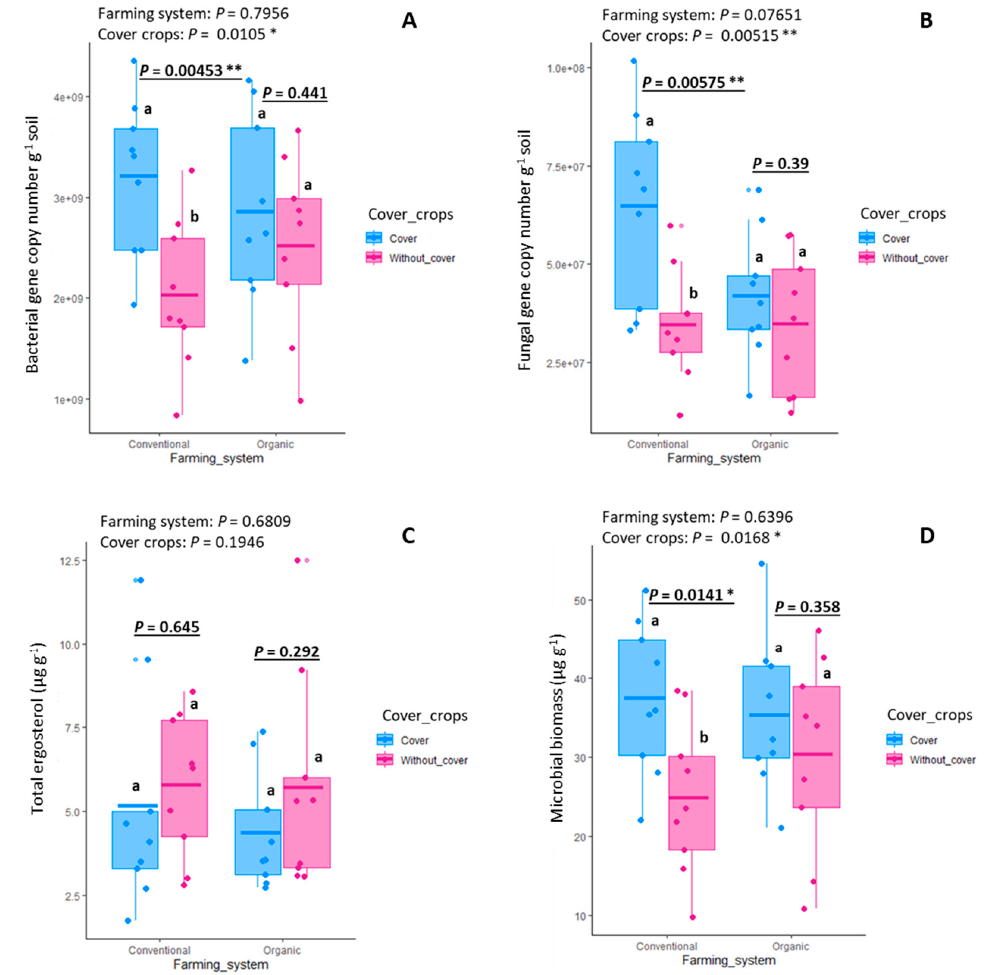
Figure 1. Effect of cover crops on bacterial abundance (16S rRNA) ( A ), fungal abundance (18S rRNA) ( B ), ergosterol content ( C ) and microbial biomass ( D ) in soil from the two farming systems (conventional and organic). The boxplot with p-values represents means of each modality using ANOVA ( n = 36). Means followed by the same letter do not differ significantly under the Tukey test at the 0.05 level; significant levels: * p < 0.05; ** p < 0.01.